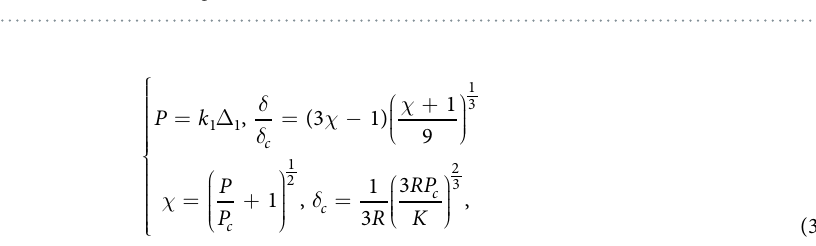
Figure 7. Calculation of the transient adhesion F ′ ad . ( a ) plot of P/P c vs. δ / δ c in Hertz (marked 1) and JKR theory (marked 2) 37 (Permitted reprint from ‘Myshkin, N. K., Petrokovets, M. I. and Kovalev, A. V. Tribol . Internat . 38 , 910–21 (2005)’); ( b ) The CCD camera image of the contact area; ( c ) change of contact radius for three types of situations (OSD and TSD with first detaching displacement = 110 and 175 μ m), measuring force during the one-step detachment and numerical fitting force-time